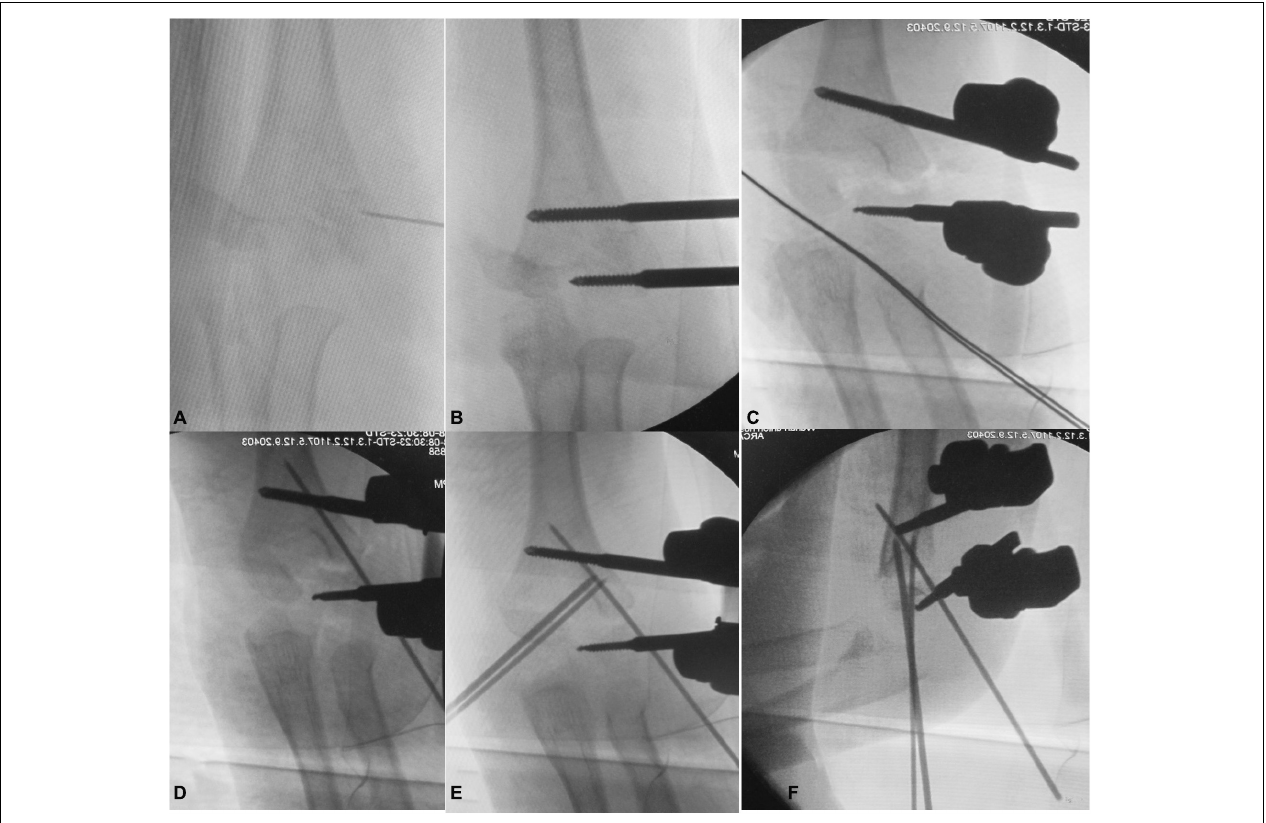
FIGURE 2 | The C-arm x-ray during operation showed: (A) the distal lateral condyle fragment located with a syringe needle; (B) placement of radial unilateral external fixation; (C) reset the lateral side of the distal humerus by closed reduction and tightened external fixation; (D) placement of the radial side anti-rotation K-wire to stable the lateral fragment; (E) placement of the ulnar K-wire to stable the medial fragment; (F) lateral view of the elbow after fixation.